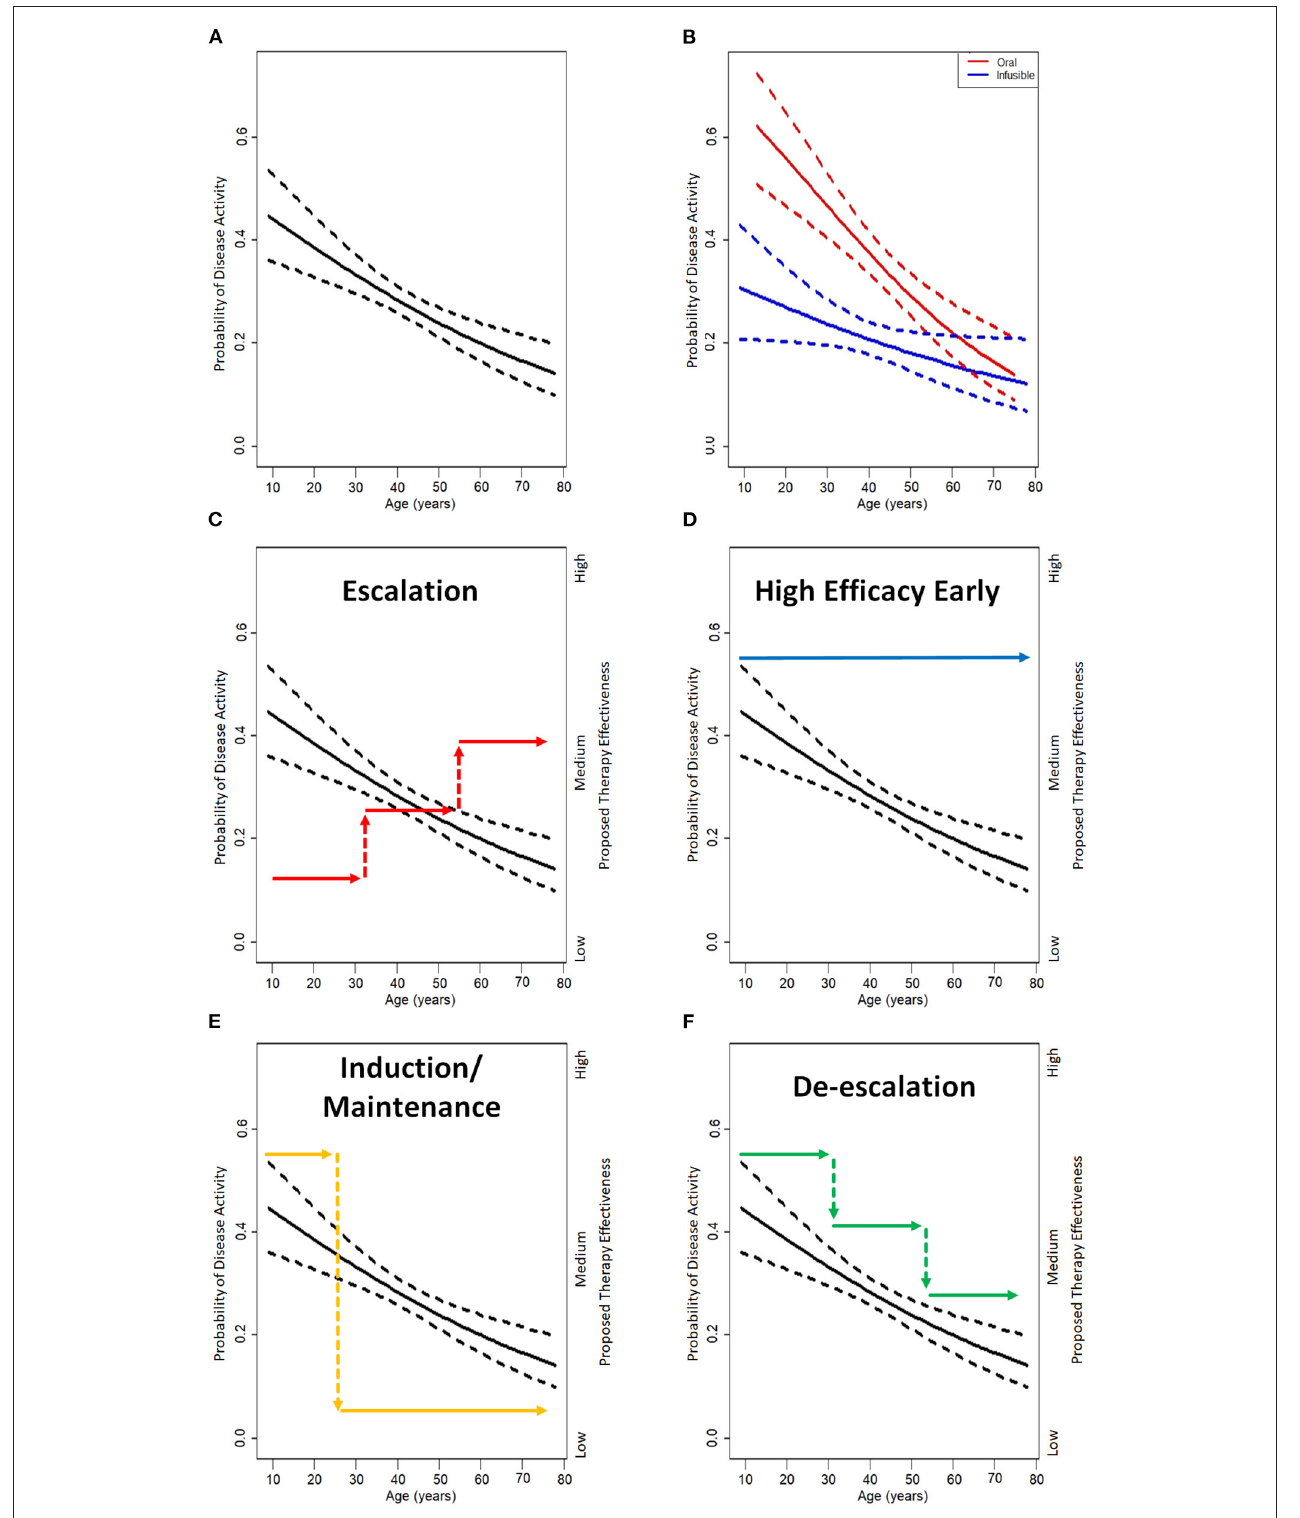
FIGURE 1 | The probability of disease activity decreases over the lifetime of a patient with MS. (A) Probability of disease activity (clinical relapse, new T2 lesions, or enhancing lesions) observed in real-world study of 1,246 patients with MS with 95% confidence interval shown in dashed lines. (B) The probably of disease activity